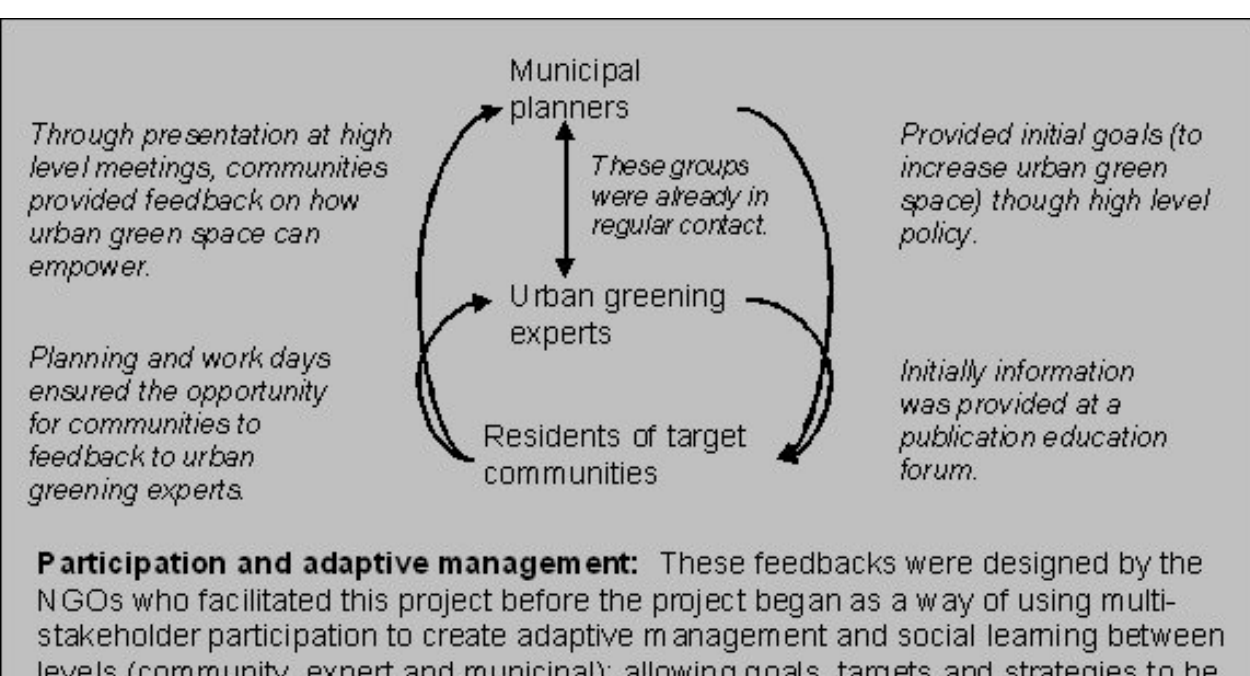
Fig. 1. Iterative steps and feedback used to apply adaptive management and community participation to green-space planning in